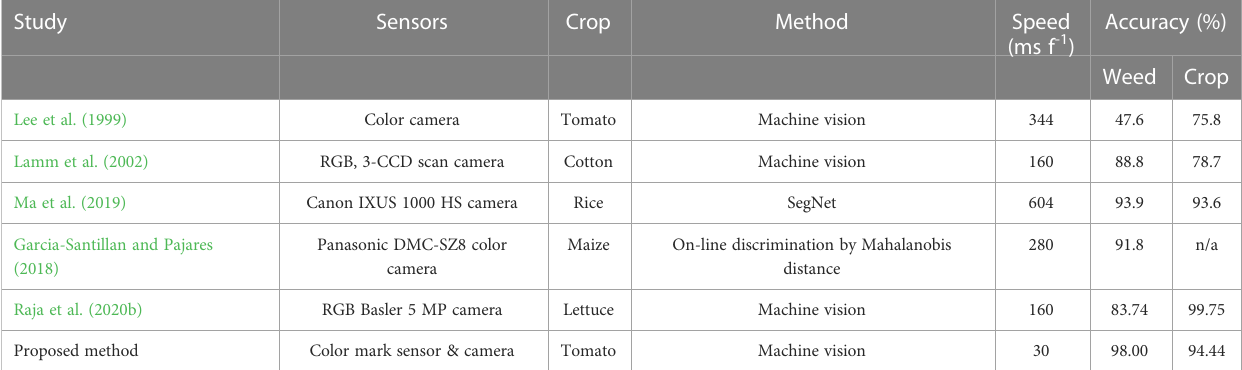
TABLE 3 Comparison of various weed and crop classi fi cation method.